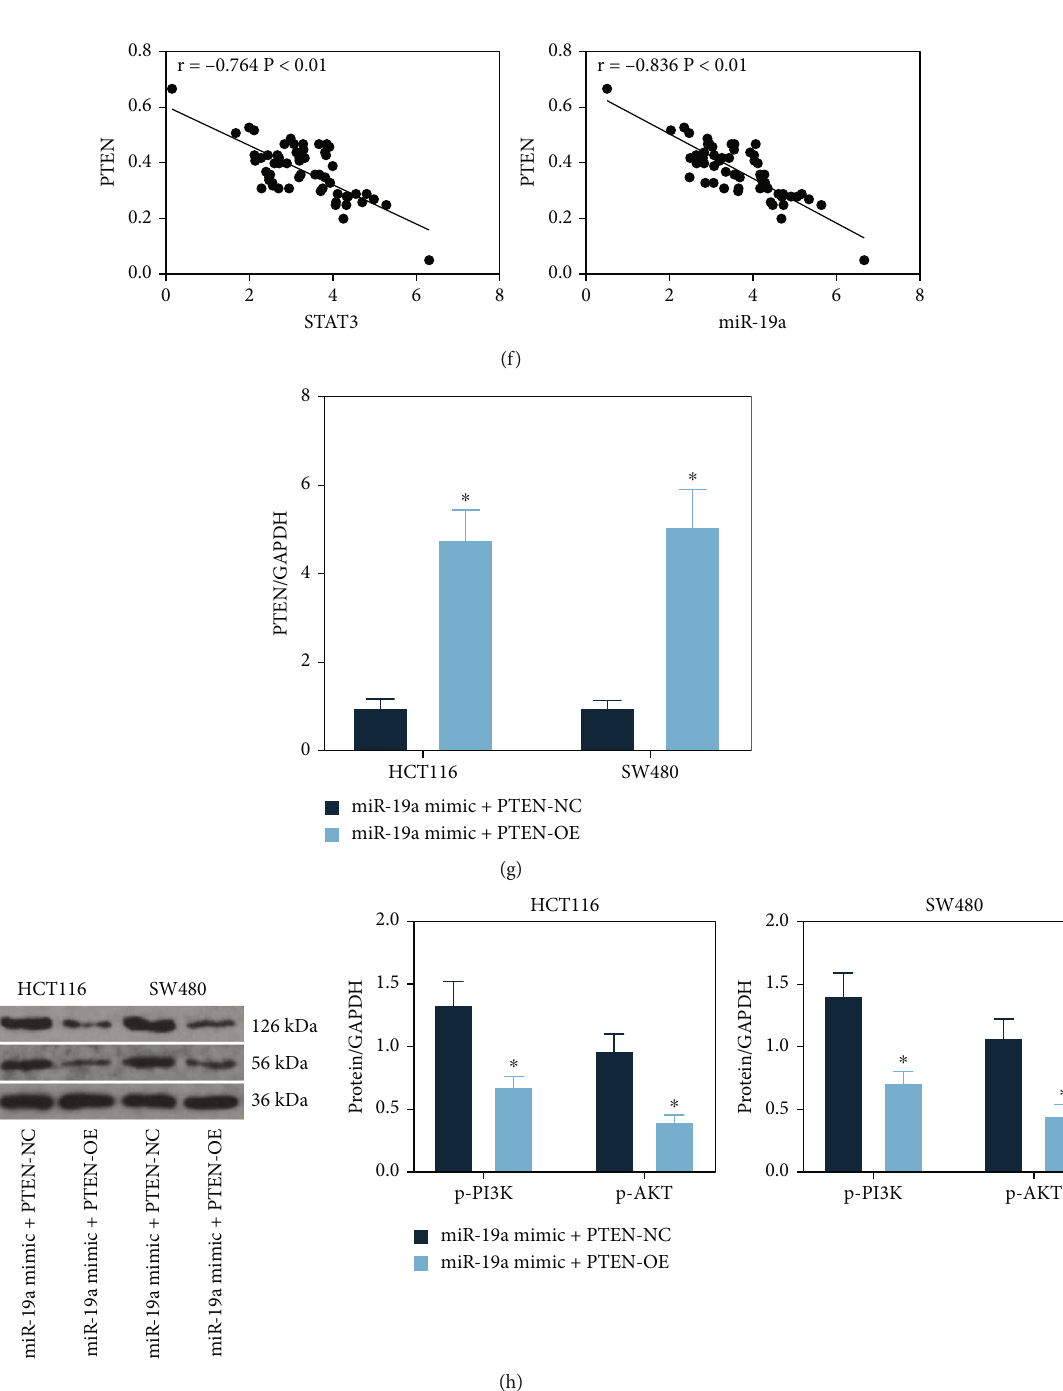
Figure 5: miR-19a directly targets PTEN mRNA in the hypoxia-exposed CRC cells: (a) a Venn diagram for the intersections of target mRNAs of miR-19a predicted using three bioinformatic systems and the mRNAs enriched in the PI3K/AKT signaling pathway; (b) expression of six candidate mRNAs in cells overexpressing miR-19a examined by RT-qPCR ( ∗ p < 0 : 05 , two-way ANOVA); (c) binding relationship between miR-19a and PTEN mRNA validated using a luciferase assay ( ∗ p < 0 : 05 , two-way ANOVA); (d) PTEN expression in the collected CRC tumor tissues and the adjacent tissues detected by RT-qPCR ( ∗ p < 0 : 05 , paired t -test); (e) PTEN expression in cells cultured under hypoxic conditions examined by RT-qPCR ( ∗ p < 0 : 05 , two-way ANOVA); (f) negative correlations between PTEN and STAT3/miR-19a in the CRC tissues ( ∗ p < 0 : 05 , Pearson ’ s correlation analysis); (g) miR-19a and PTEN mRNA expression in cells after miR-19a mimic and PTEN-OE transfections examined by RT-qPCR ( ∗ p < 0 : 05 , two-way ANOVA); (h) phosphorylation of PI3K and AKT in cells detected by the western blot analysis ( ∗ p < 0 : 05 , two-way ANOVA). Data were presented as the mean ± SD from three independent